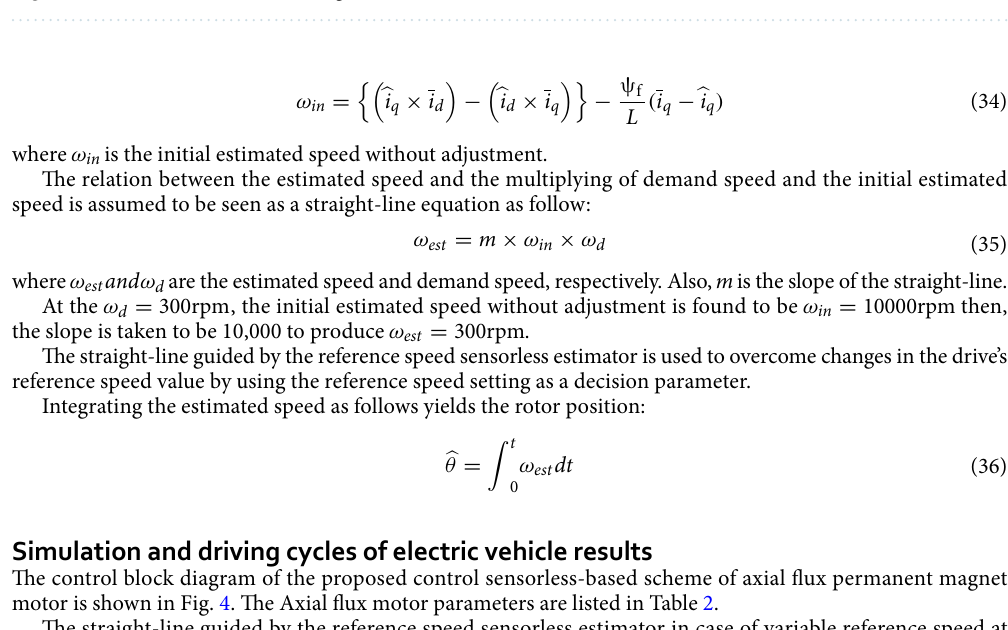
Figure 4. Sensorless DTC block diagram with SVPWM for